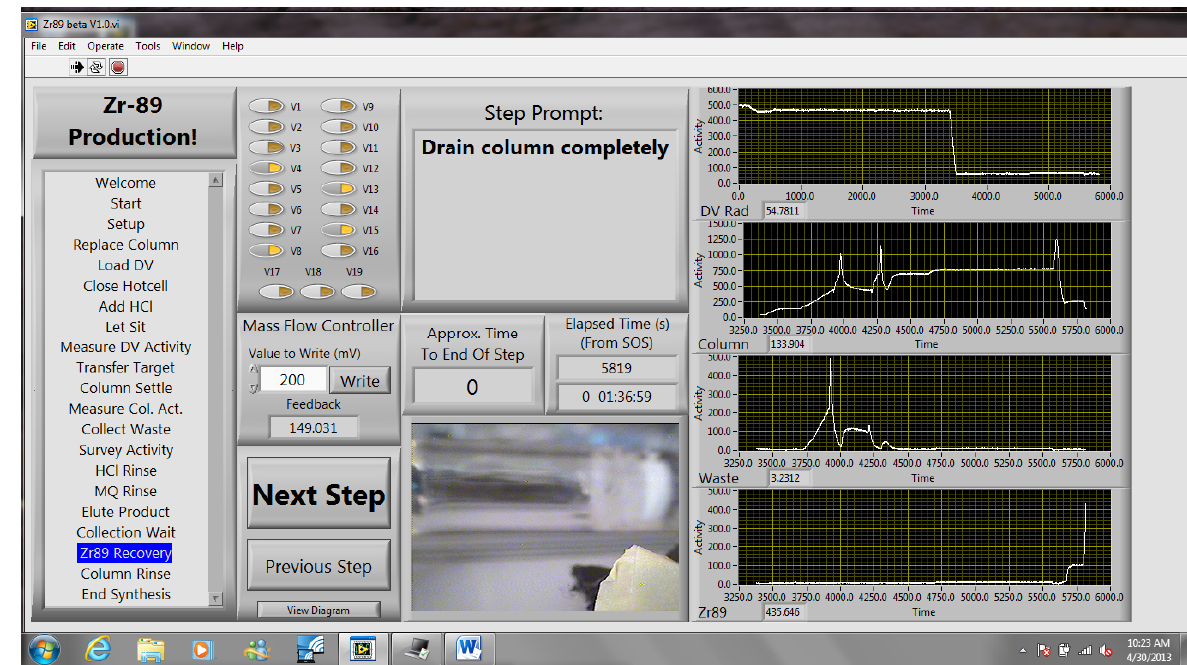
Figure 4. Screenshot of the window containing the graphical user interface (GUI) that was used to control the automated module. This image was captured near the end of the separation process. Notice that the time scales for the bottom three graphs match each other but differ from the graph for the dissolution vessel (DV) as it begins to collect data earlier in the